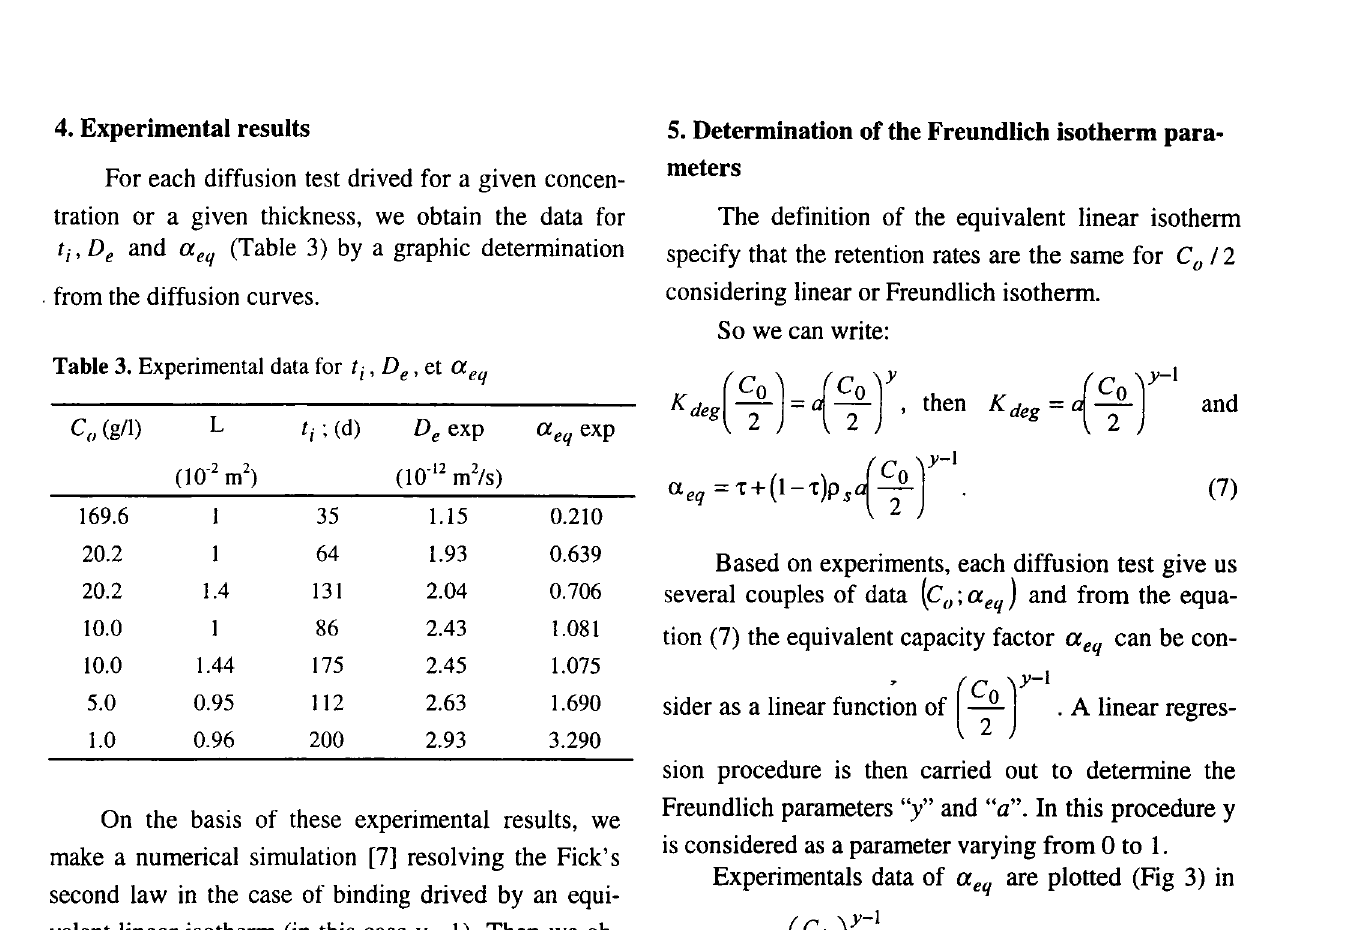
Table 4. Adjusted data obtained by numerical